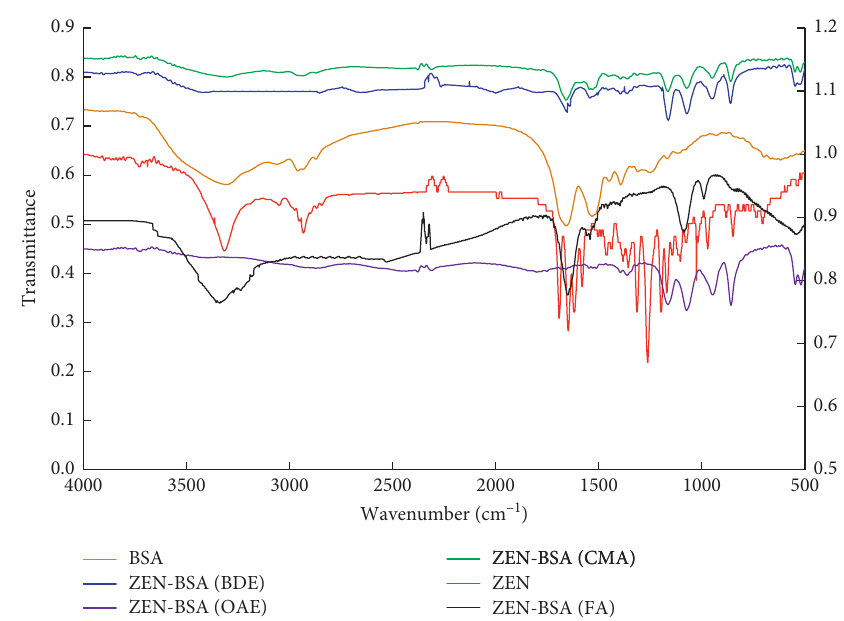
Figure 6: IR spectra of ZEN-BSA synthesized by four methods. (Figure 7). The artificial immunogen ZEN-BSA synthesized